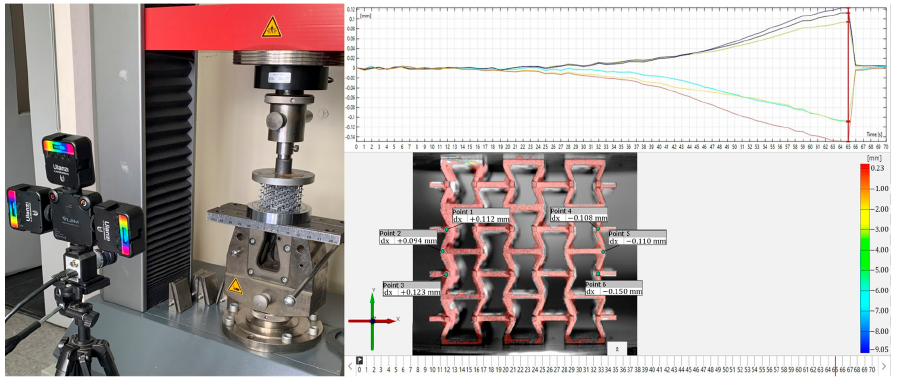
Figure 6. Quasi ‐ static compression tests on each proposed macrostructure in its three orthogonal directions.